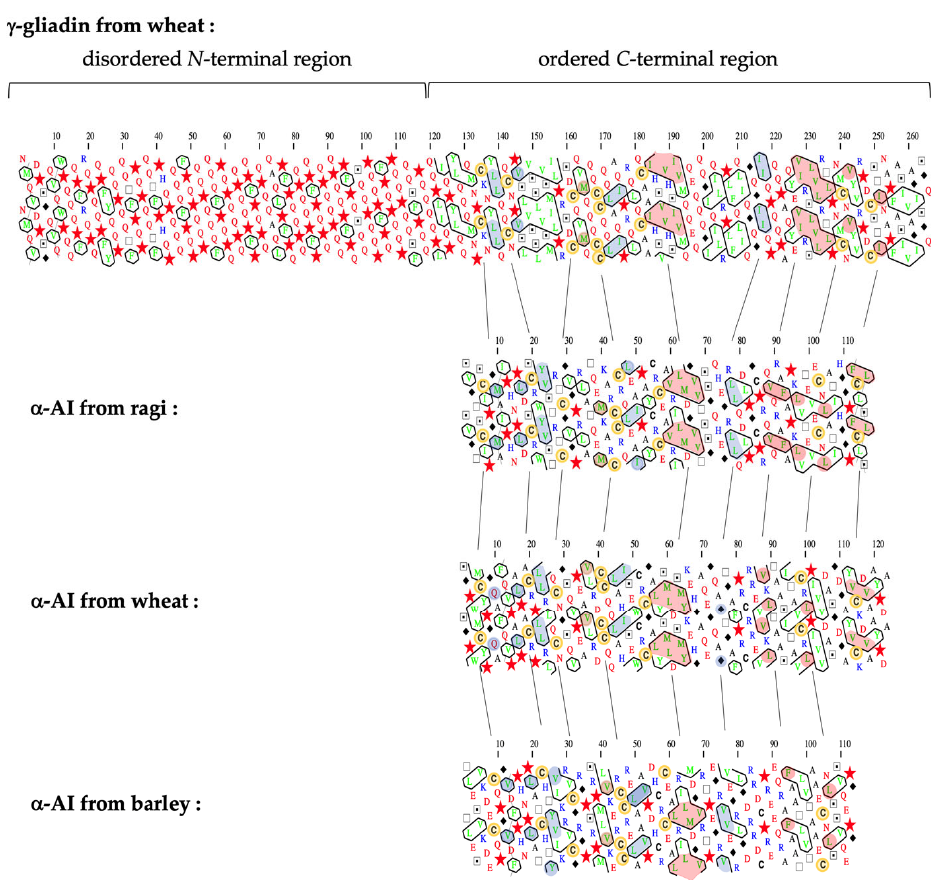
Figure 2. Comparison of the HCA plot for γ 3-gliadin from wheat with the HCA plots from α -amylase inhibitors from ragi, wheat and barley, showing the structural homologies of the inhibitors with the ordered C-terminal part of the gliadin. Homologous cysteine and hydrophobic cluster residues are colored yellow and red or blue, respectively.